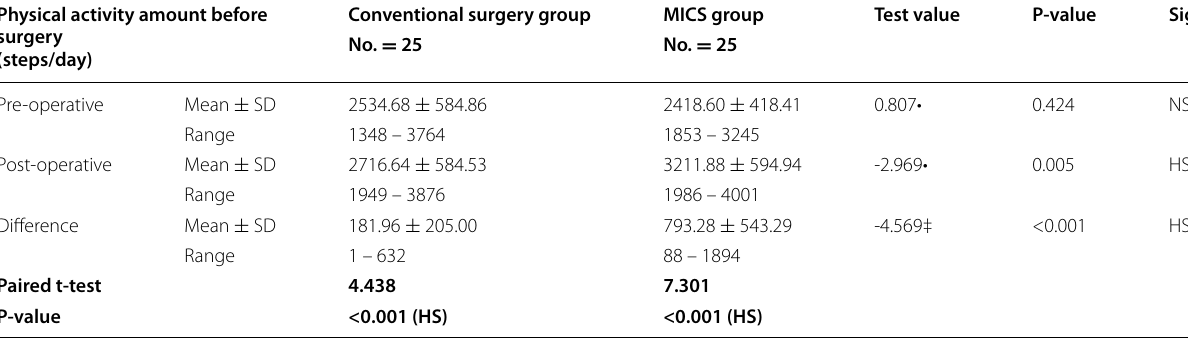
P is significant at 0.05, P is highly significant (HS) at ≤